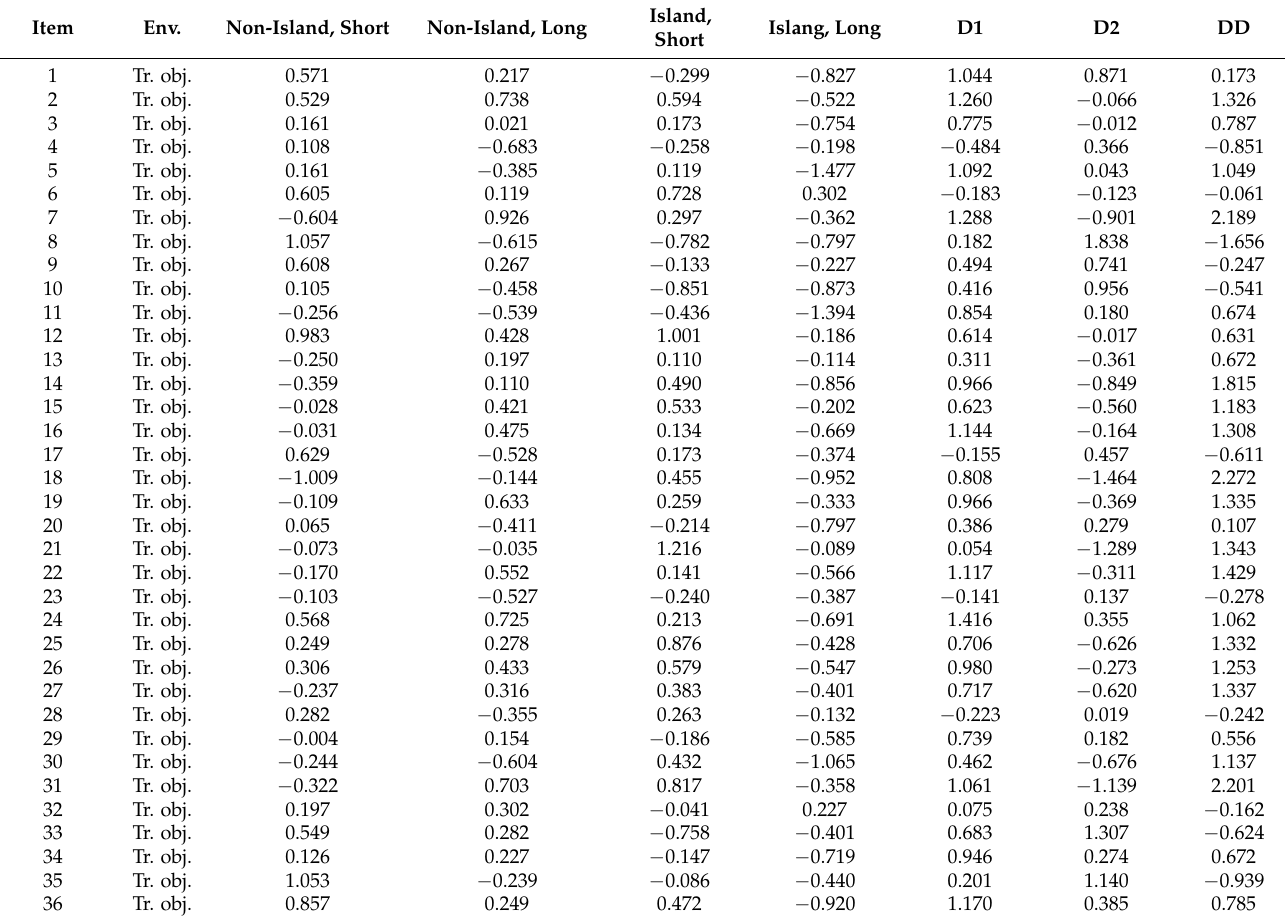
Table A6. DD score calculation table for Experiment 1, Transitive object conditions. The table displays the z-scored ratings for each condition and the intermediate differences used to calculate the DD score by item. Refer to Section 2 for a description of the procedure for calculating DD scores. The DD scores below are averaged for the Transitive object environment and presented in Figures 2 and